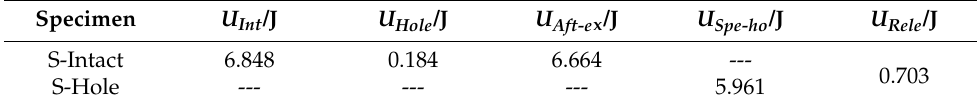
Figure 4. Load versus displacement curve of four specimens. Table 2. The strain energy of each part.